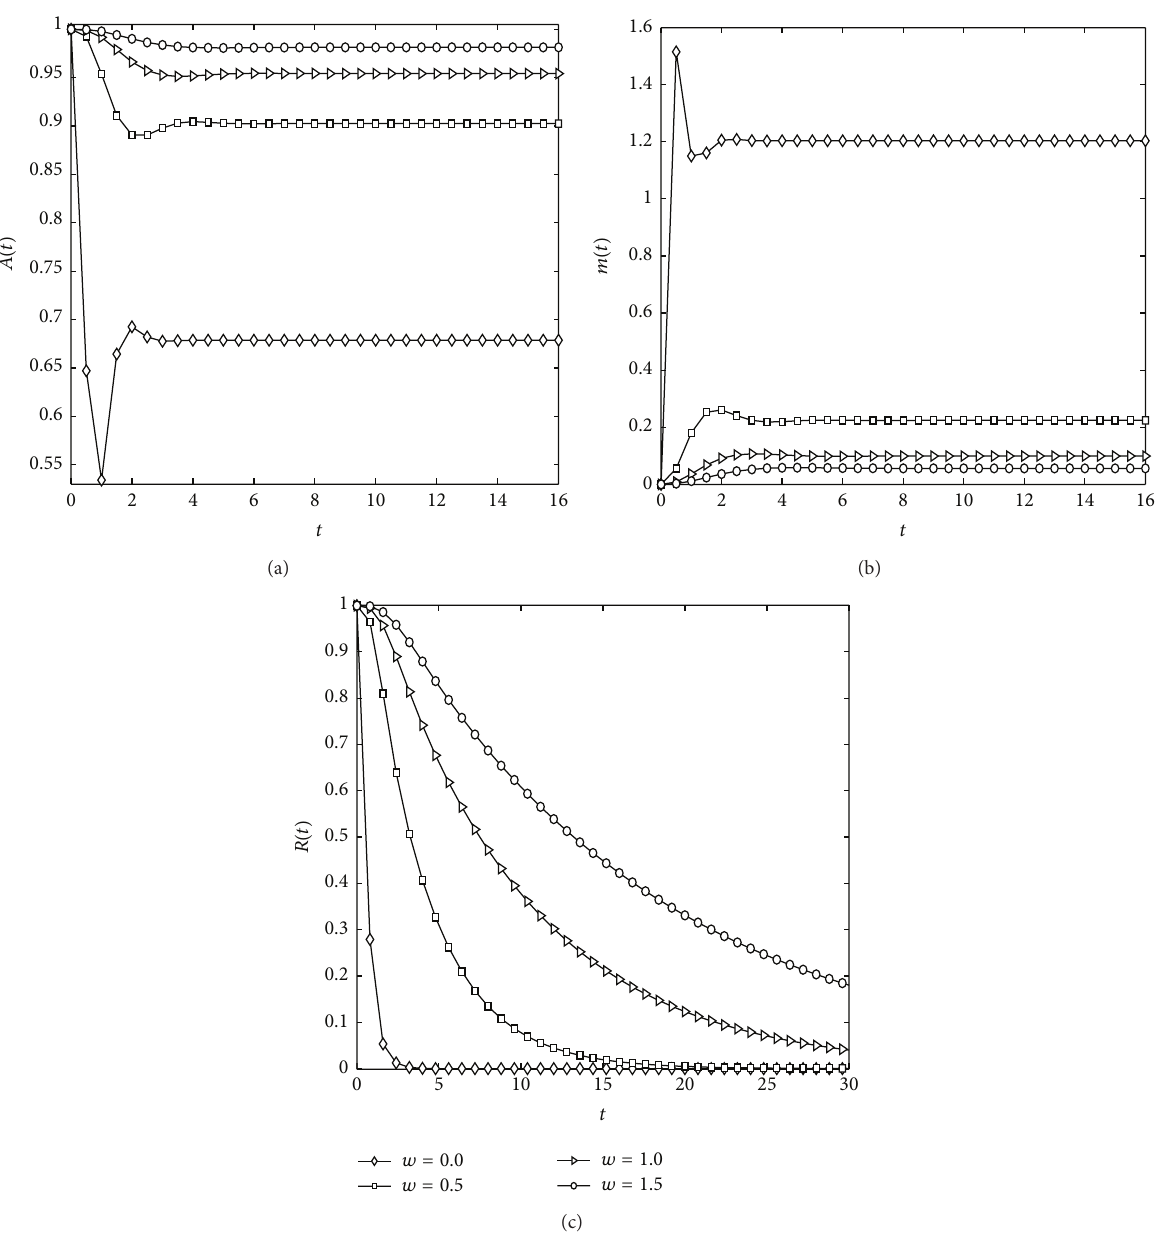
Figure 3: Illustration of the system reliability measures under different values of 𝑤